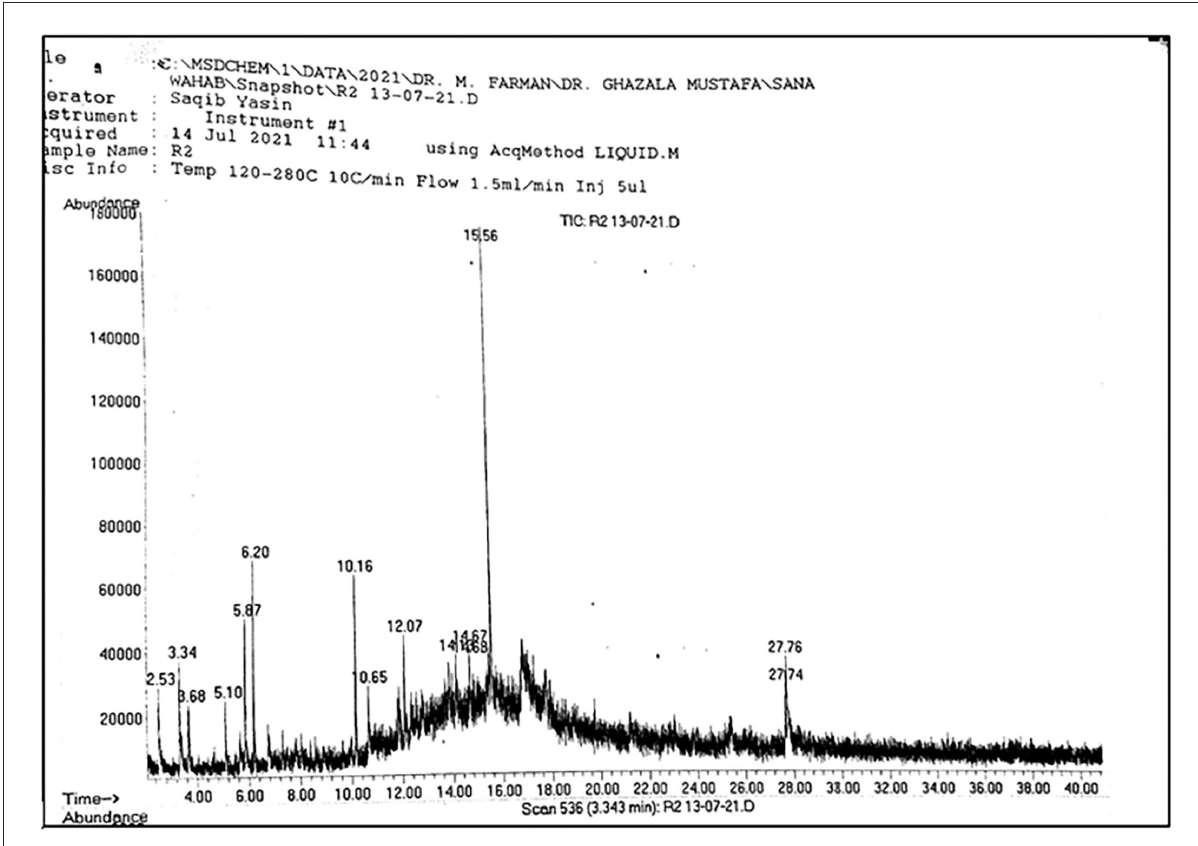
FIGURE5 Main spectrum showing different peaks observed in Rhizome